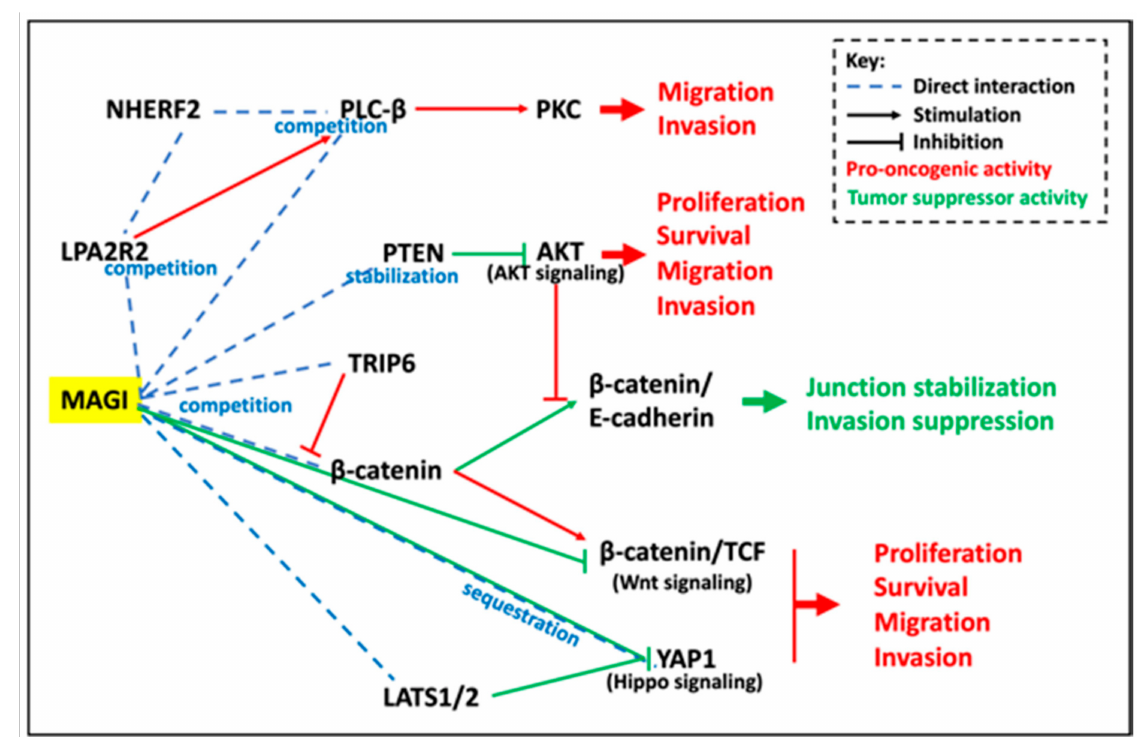
Figure 3. Schematic overview of the main MAGI interacting partners and effectors systems, and their biological impacts. The selective interaction of MAGIs with their molecular partners enables controlling concurrently several interconnected pathways involved in cell proliferation, survival, and dissemination. The recruitment of PTEN to the E-cadherin/ β -catenin junctional complexes stabilizes PTEN, decreases both PI3K/AKT and Wnt signaling. MAGIs also act at many levels of the Hippo signaling pathways, and by competitive interaction overcome the activity of other signalosomes including NHERF. For details see the